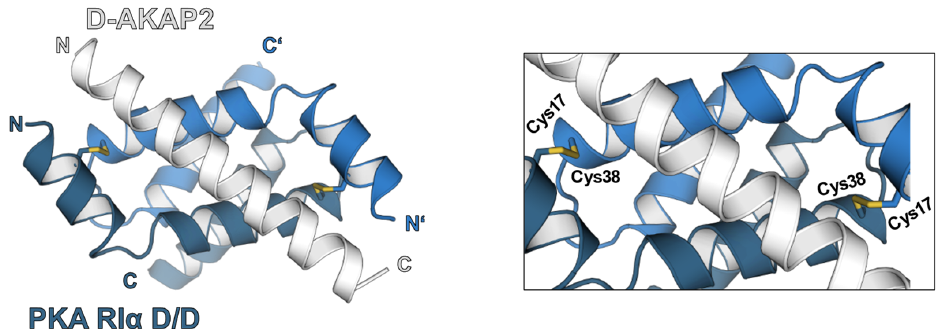
Figure 2. Structure of PKA-RI α dimerization and docking domain (D/D-domain) in complex with D-AKAP2 [52] (PDB 3IM4) . The RI α D/D-domain (blue and dark blue) is defined by an N-terminal